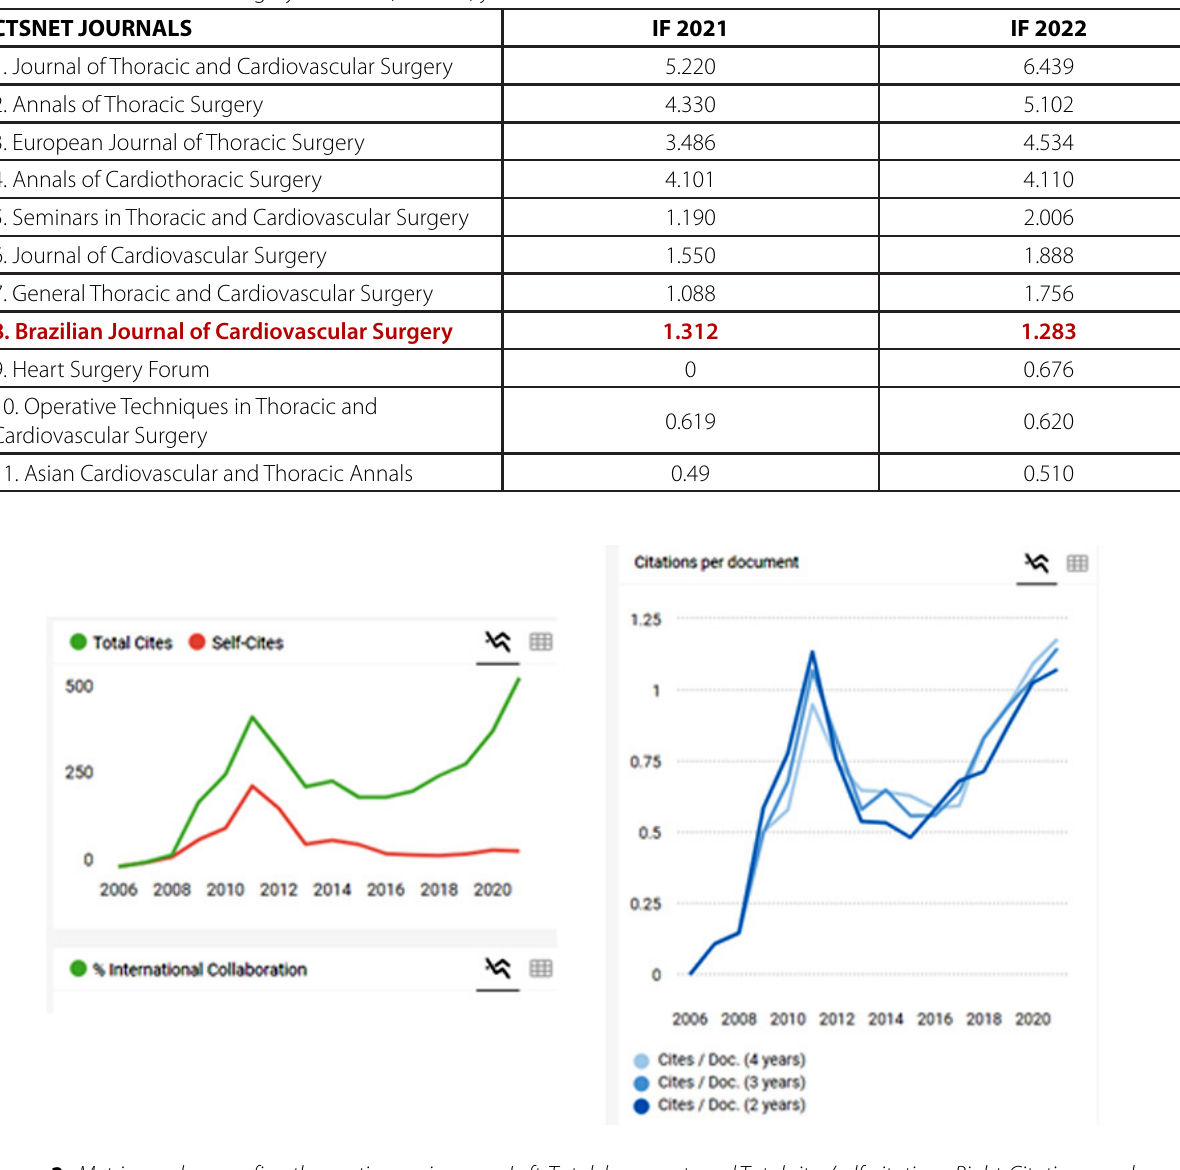
Figure 2 - Metric numbers confirm the continuous increase. Left: Total documents and Total cites/self-citations; Right: Citations per